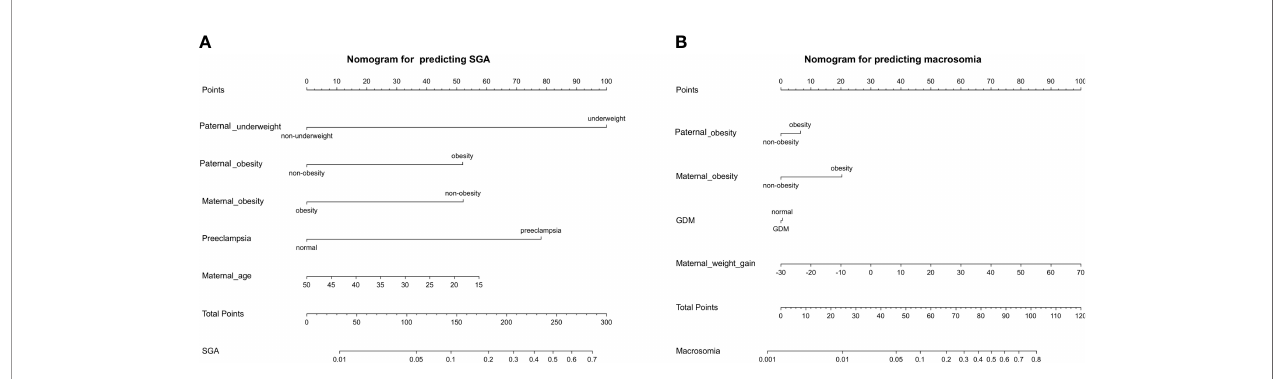
FIGURE 3 | The nomogram was developed to predict the incidence rate of SGA (A) and macrosomia (B) based on the signi fi cant predictors in the multivariable analysis. Draw an upward vertical line from each variable axis to obtain the point of each variable. Calculate the sum of each variable score and draw an upward vertical line from the total score axis to obtain the predicted incidence of SGA